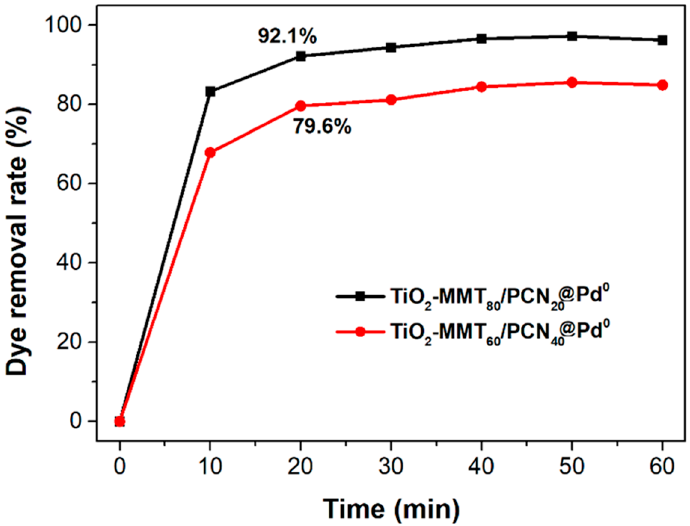
Figure 6. Adsorption removal rate of rhodamine B from the aqueous solution using the TiO 2